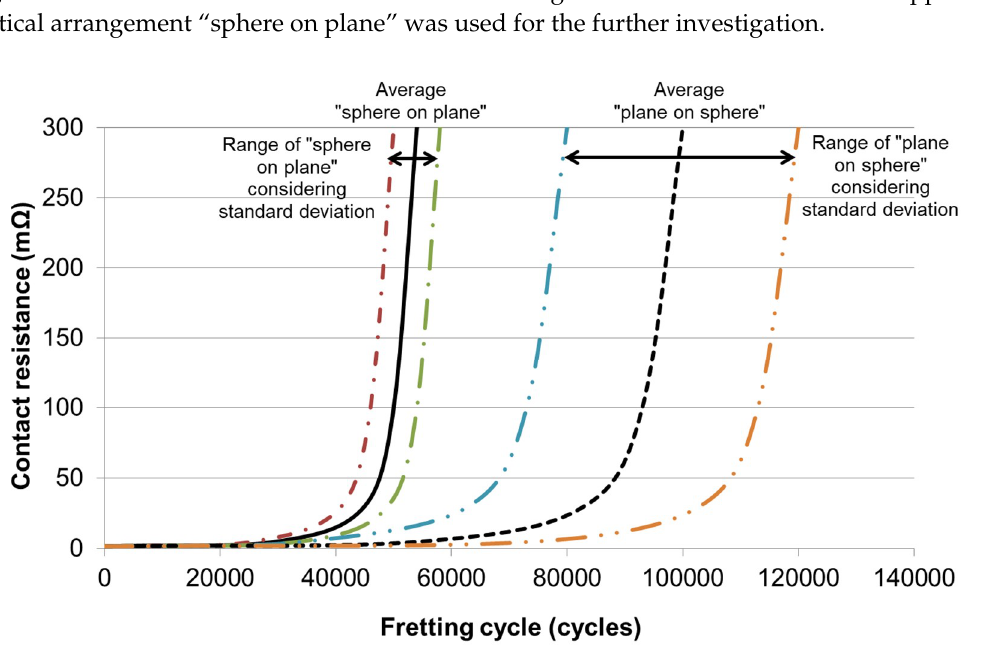
Figure 5. Development of contact resistance during tests. Table 2 . Lifetime of the electrical contacts with different arrangements .